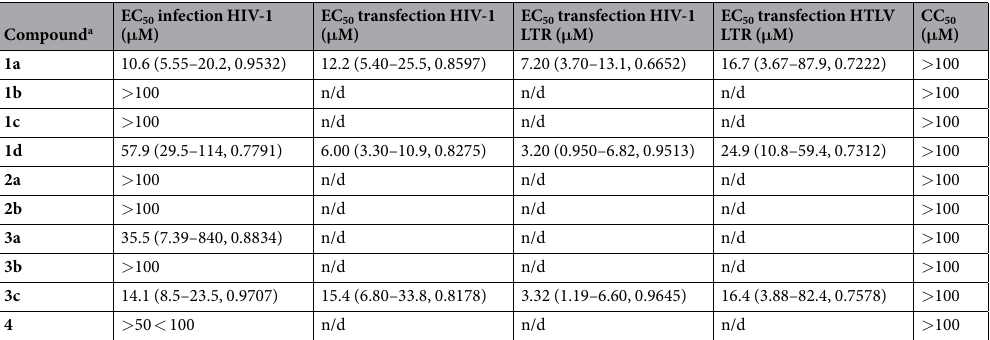
Table 3. Results of cellular assays for 1,4-terphenyl compounds. Inhibitory activity (EC 50 ) in experiments based on infection with HIV virus and transfection with HIV- and LTR-dependent vectors, and cellular toxicity (CC 50 ). a Confidence intervals and R 2 values are shown in parentheses when applicable; n/d: not